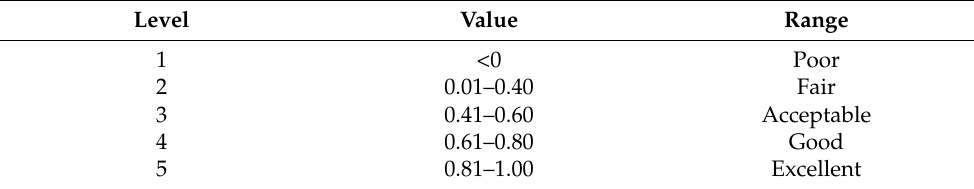
Table 4. Possible ranges of map comparison and level of agreement of Kappa coefficient ( K ). Level